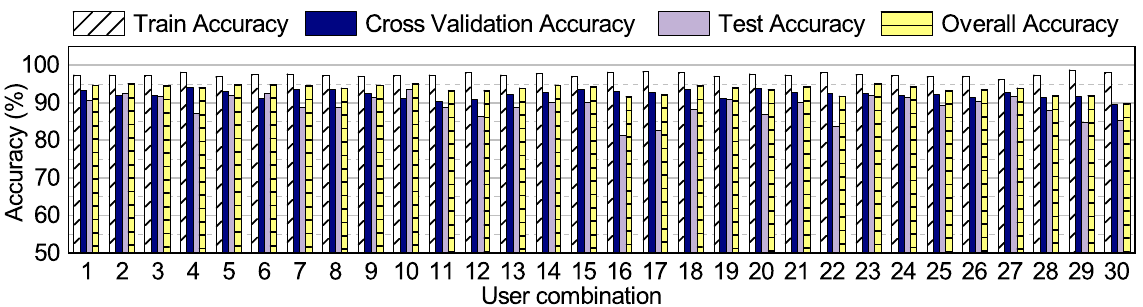
Figure 7. Comparison of recognition accuracy with different combinations of users for